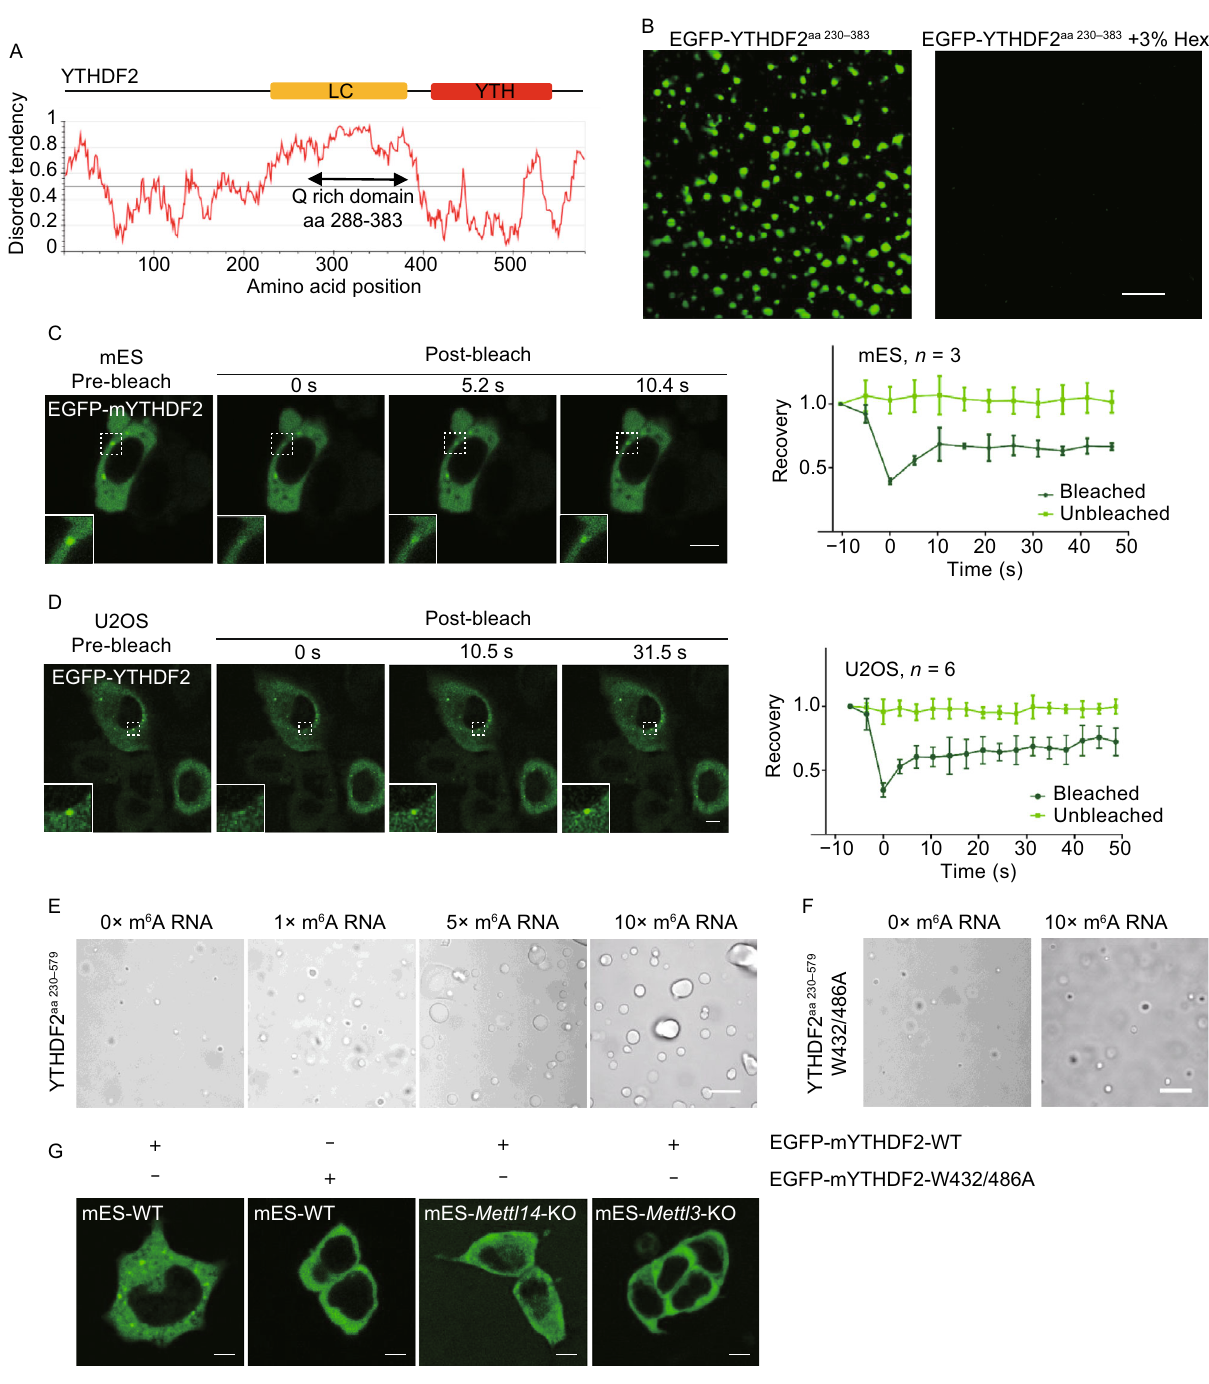
Figure 1. Phase separation of YTHDF2 in vivo / vitro . (A) Top: Diagram of protein domains of YTHDF2. Bottom: predictions of Intrinsic disorder tendency of YTHDF2 by IUPred2A (https://iupred2a.elte.hu/). Scores above 0.5 indicate disorder. (B) Liquid phase separation of YTHDF2 aa 230 − 383 (23 μ mol/L YTHDF2, 37 mmol/L NaCl, 10% PEG8000) was sensitive to 1,6-hexanediol (1,6-hex; 3%). Scale bar, 10 μ m. (C and D) EGFP-YTHDF2 was exogenously expressed in mES cells (C) or U2OS cells (D). FRAP assays showed YTHDF2 forms LLPS in both cell lines (Left). The line traces represent mean fractional fl uorescence (Right). Scale bar, 5 μ m (C), 10 μ m (D). (E) m 6 A oligos induced liquid like droplet formation of YTHDF2 aa 230 − 579 (58 μ mol/L YTHDF2, 33 mmol/L NaCl, 17 μ mol/L RNA oligos). Scale bar, 10 μ m. (F) m 6 A oligos could not induce liquid like droplet formation of W432A/W486A mutated YTHDF2 aa 230 − 579 (58 μ mol/L YTHDF2, 33 mmol/L NaCl, 17 μ mol/L RNA oligos). Scale bar, 10 μ m. (G) Wildtype, but not W432A/W486A mutated EGFP- YTHDF2 formed droplets in mESCs. Wildtype EGFP-YTHDF2 failed to form droplets in Mettl14 or Mettl3 KO mESCs. Scale bar, 5 μ